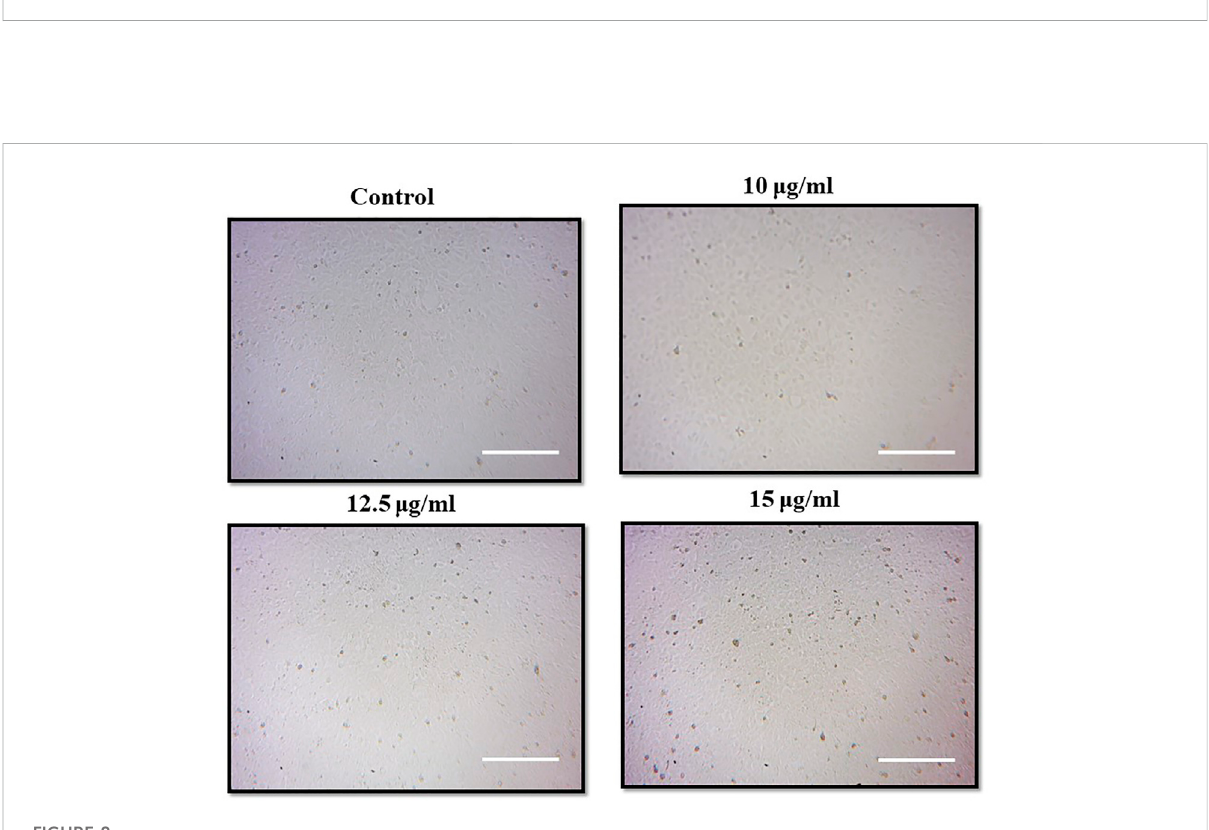
FIGURE 8 Morphological changes in PA-1 cells after the treatment with